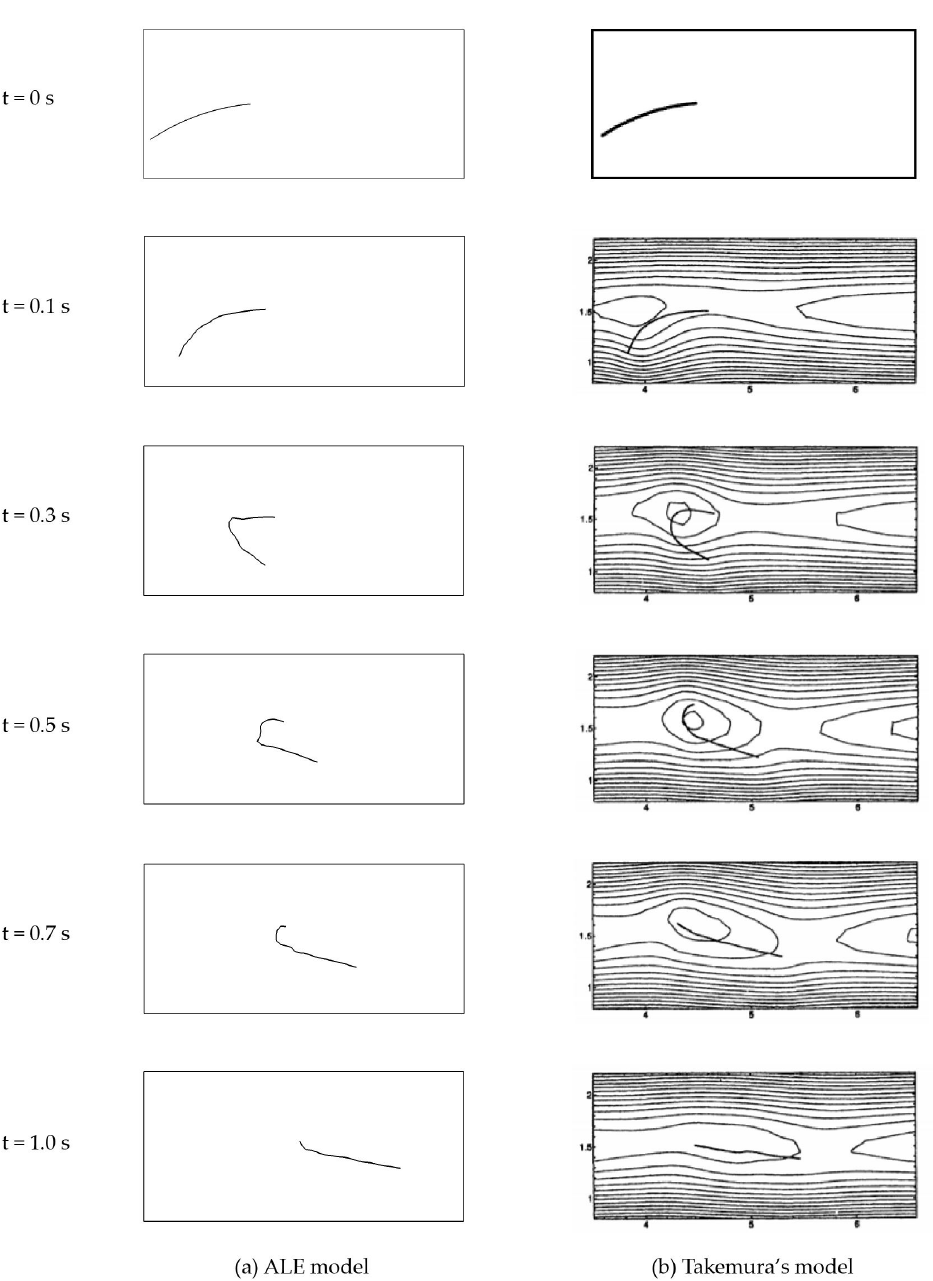
Figure 19. Evolutions of the fibre configuration. ( a ) ALE model. ( b ) Model in [44] (Figure